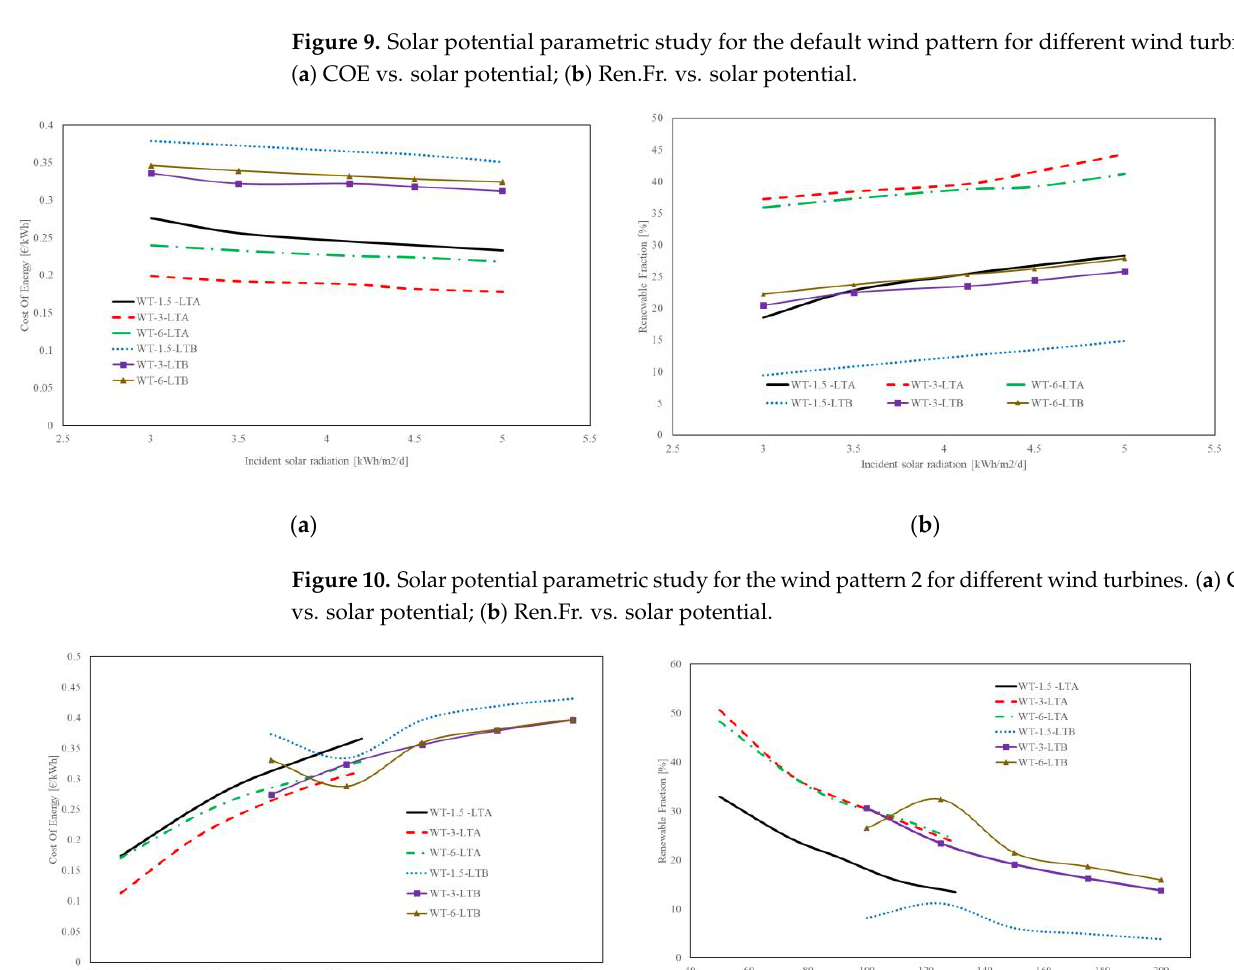
Figure 9. Solar potential parametric study for the default wind pattern for different wind turbines. ( a ) COE vs. solar potential; ( b ) Ren.Fr. vs. solar potential